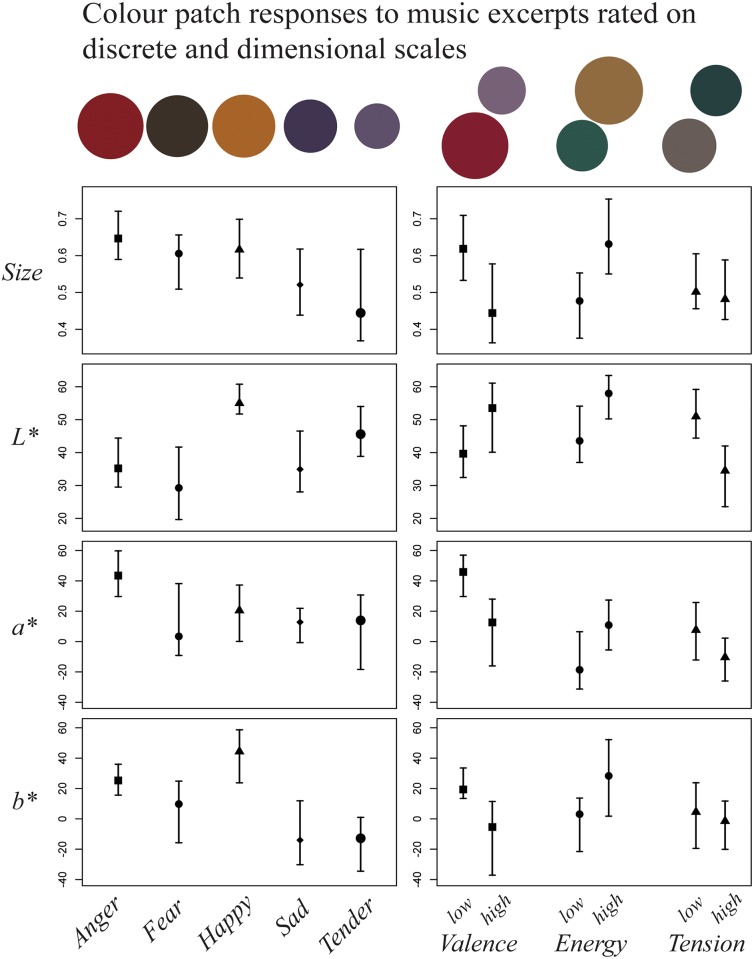
Colour patches and error bars for Size, Lightness, a* (green-to-red), and b* (blue-to-yellow) for film music excerpts expressing five discrete emotions and low or high dimensional emotion.Colour patch ranges as in Table 2. Median values with bootstrapped 95% confidence intervals around the median (5000 simulations each). Note that the colour plots are for illustration only. Their appearance might be approximate, as colour reproduction depends on encoding, screen setting, and so forth. For patch size, see the Procedure section.